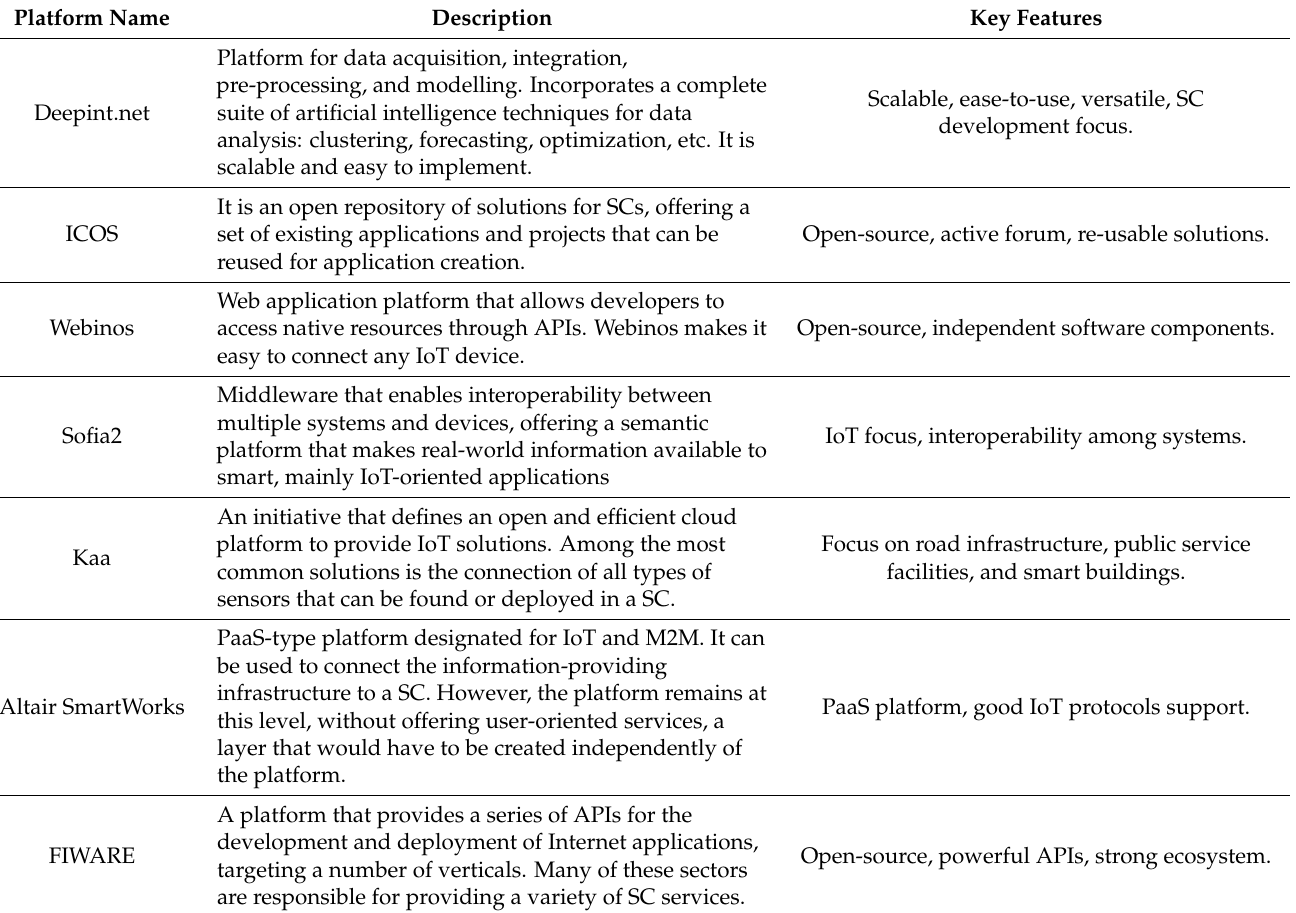
Table 1. Main platforms used for the management of smart